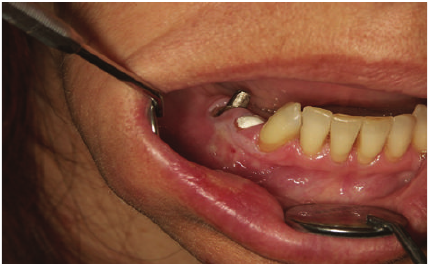
Figure 5: Chemical burn of the gingiva and labial lower mucosa caused by sodium